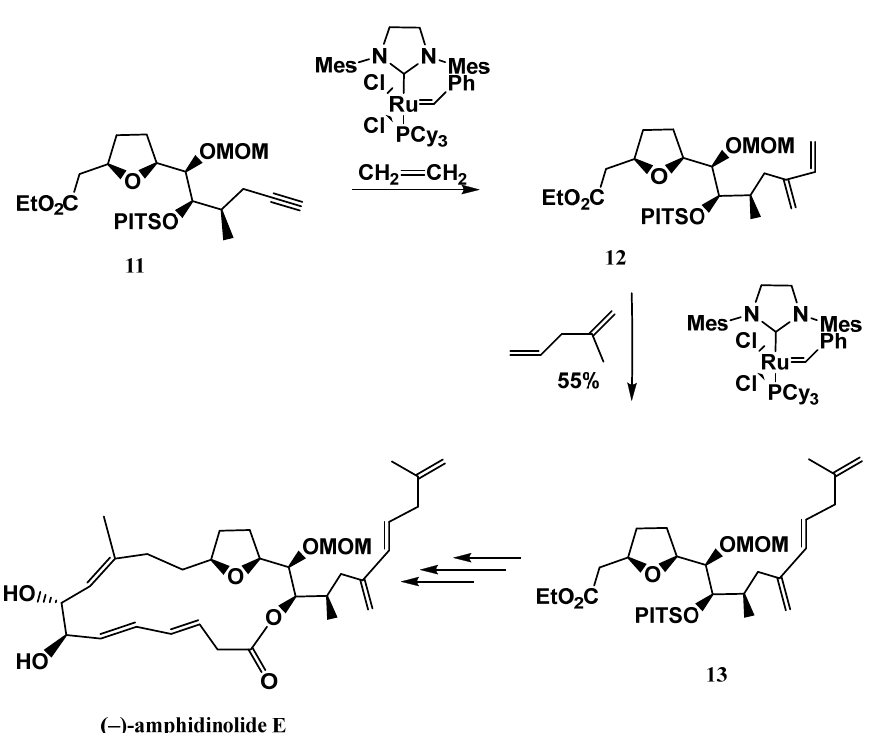
Table 7. Cheng et al.’s cobalt Table 7. Cheng et al.’s cobalt coupling. Table 7. Cheng et al.’s cobalt coupling. Table 7. Cheng et al.’s cobalt coupling. Table 7. Cheng et al.’s cobalt coupling.